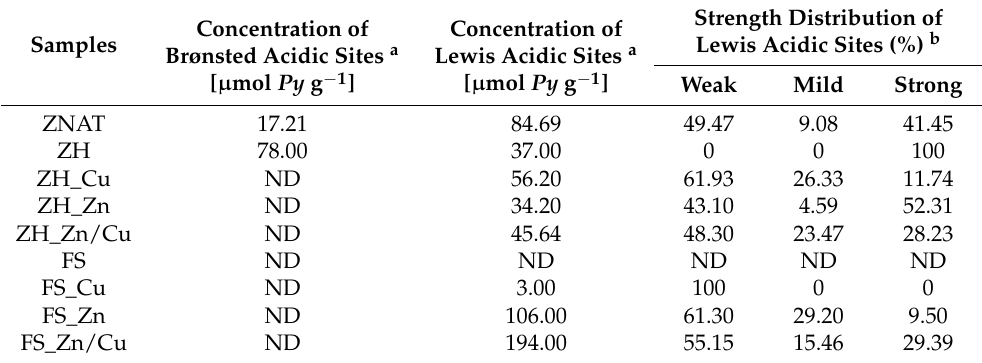
Table 3. Characterization of the nature and strength of acidic surface sites of parent supports and prepared single and double metal oxide catalysts by in situ FTIR analyses using pyridine.